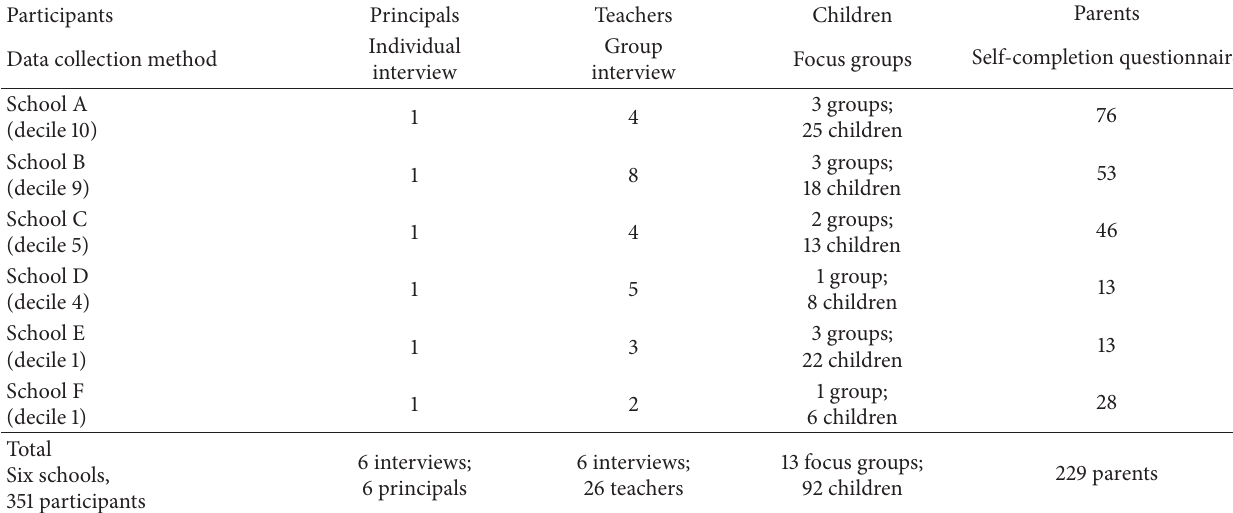
Table 1: Summary of research participants and data collection